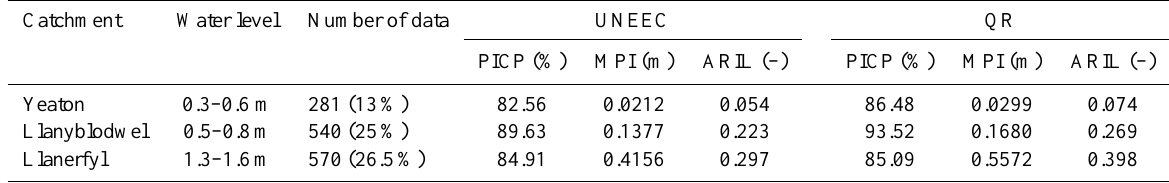
Table 4. PICP, MPI, and ARIL values for MEDIUM water levels (validation, 90% confidence level): UNEEC vs. QR.